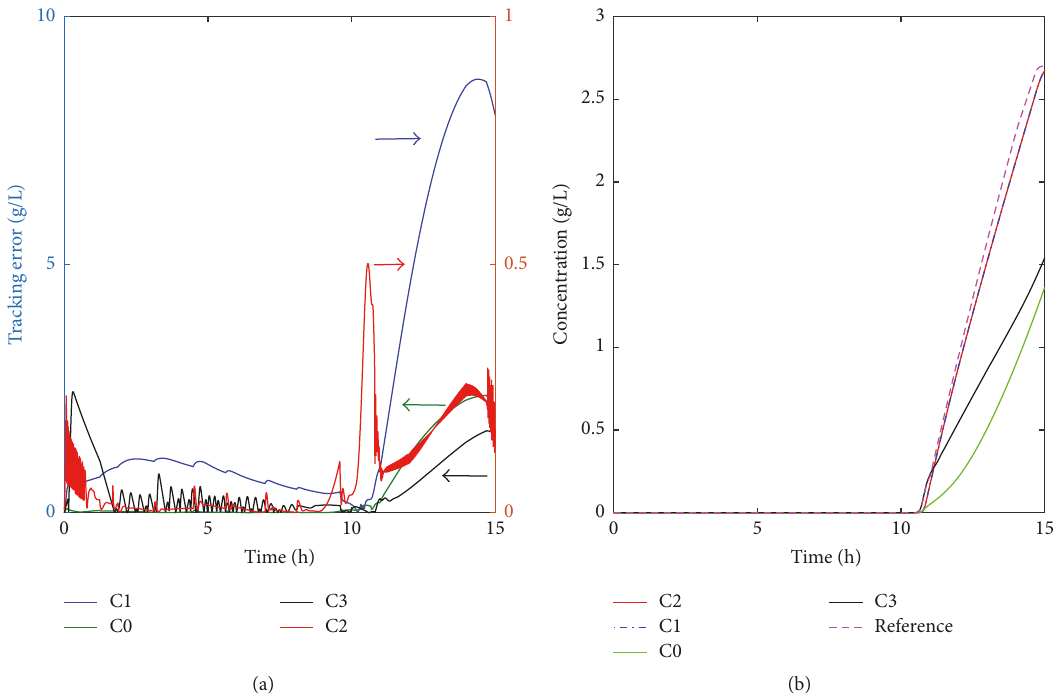
Figure 2: (a) Comparison of the tracking errors (see (31)) (left ordinate axis: C0 and C3; right axis: C2 and C1). (b) Total protein concentration profiles: C1 and C2 successfully reach the maximum production of protein in the presence of time-varying parameters.